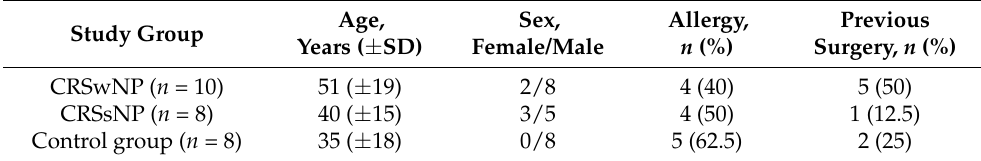
Table 1. Patients’